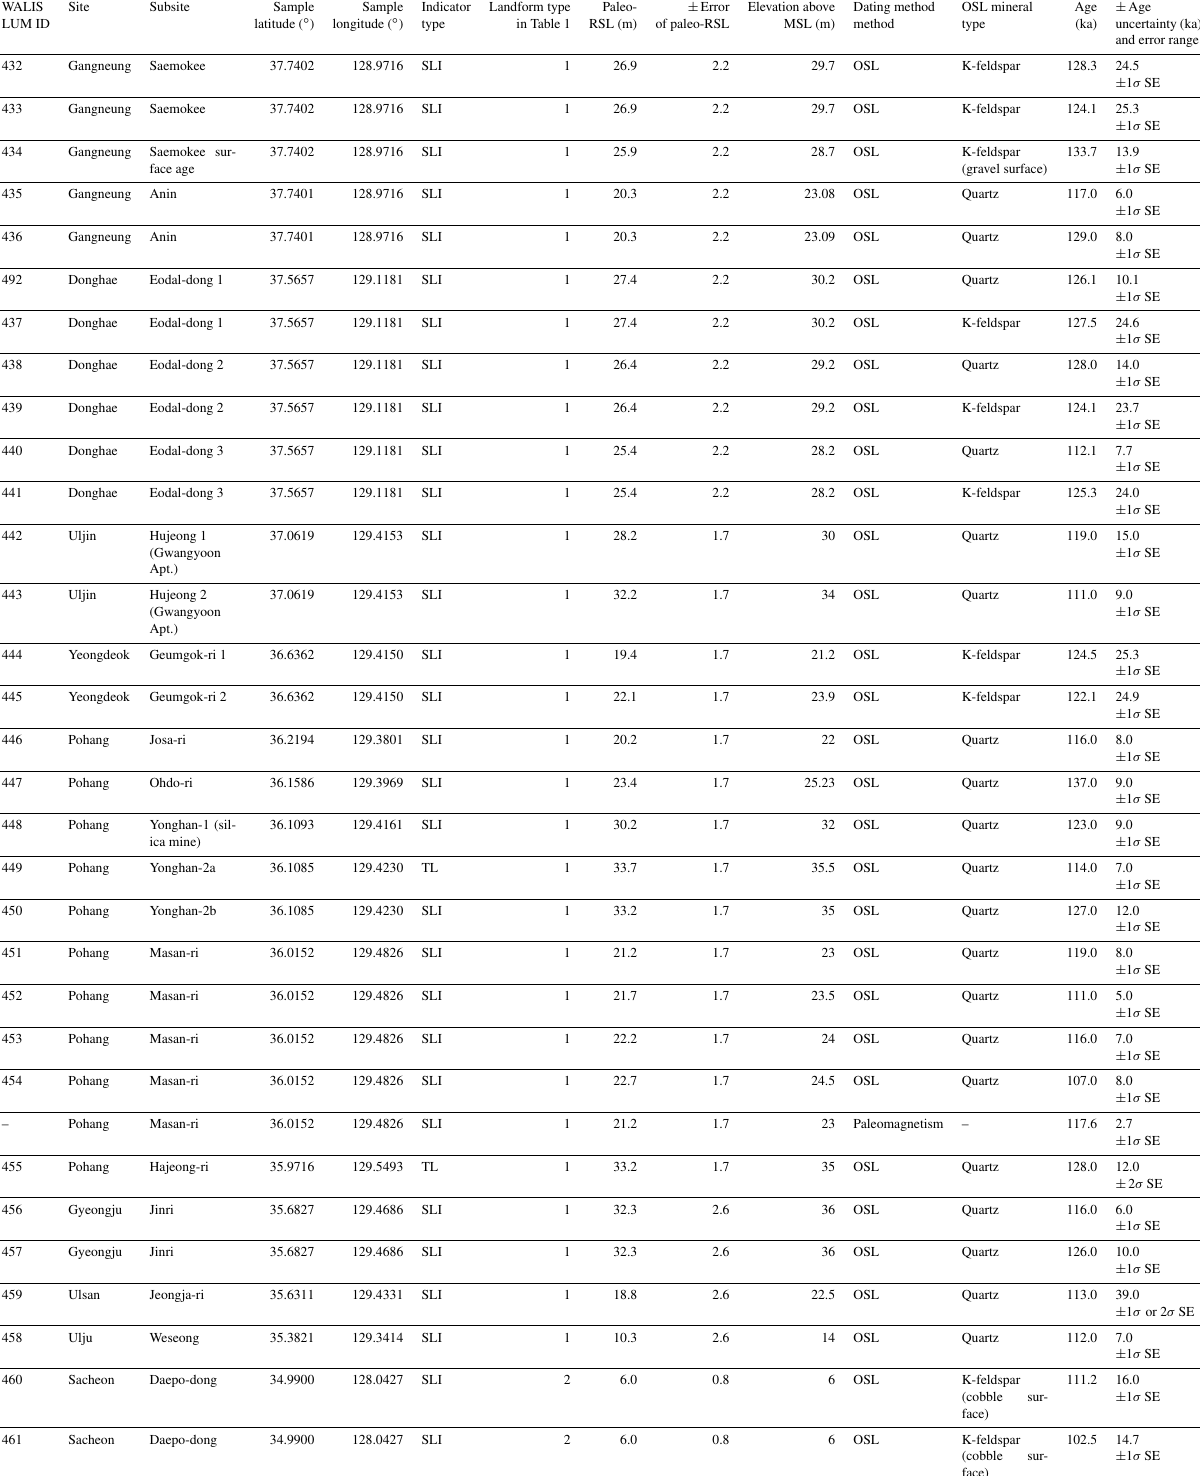
Table 3. Summary of LIG relative sea levels and ages as data points in the Korean Peninsula. For references, refer to the text. SLI: sea-level indicator; TL: terrestrial limiting record; ML: marine limiting